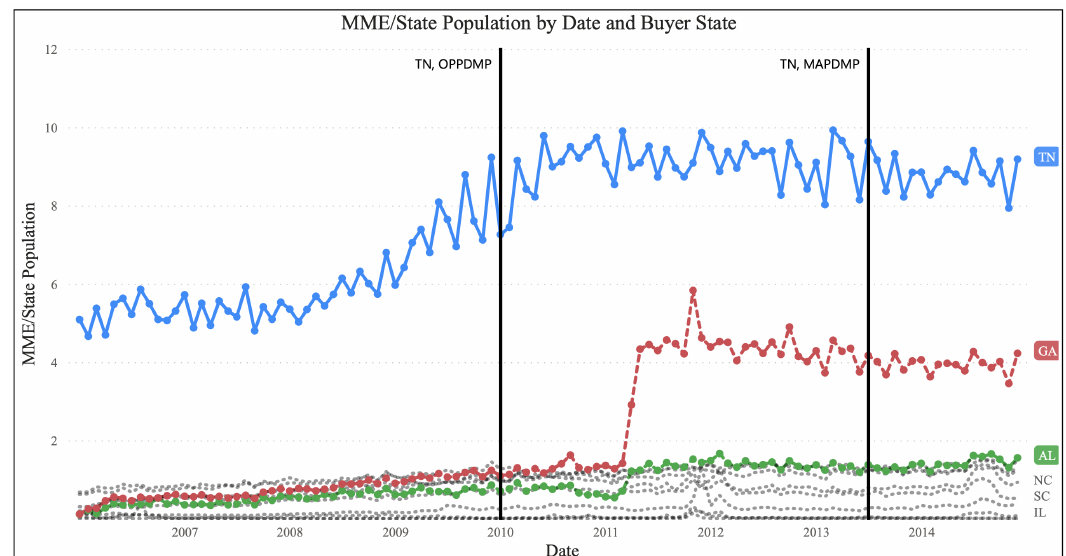
Figure 3. Trend of PCPV, excluding manufacturing buyers; source: ARCOS.